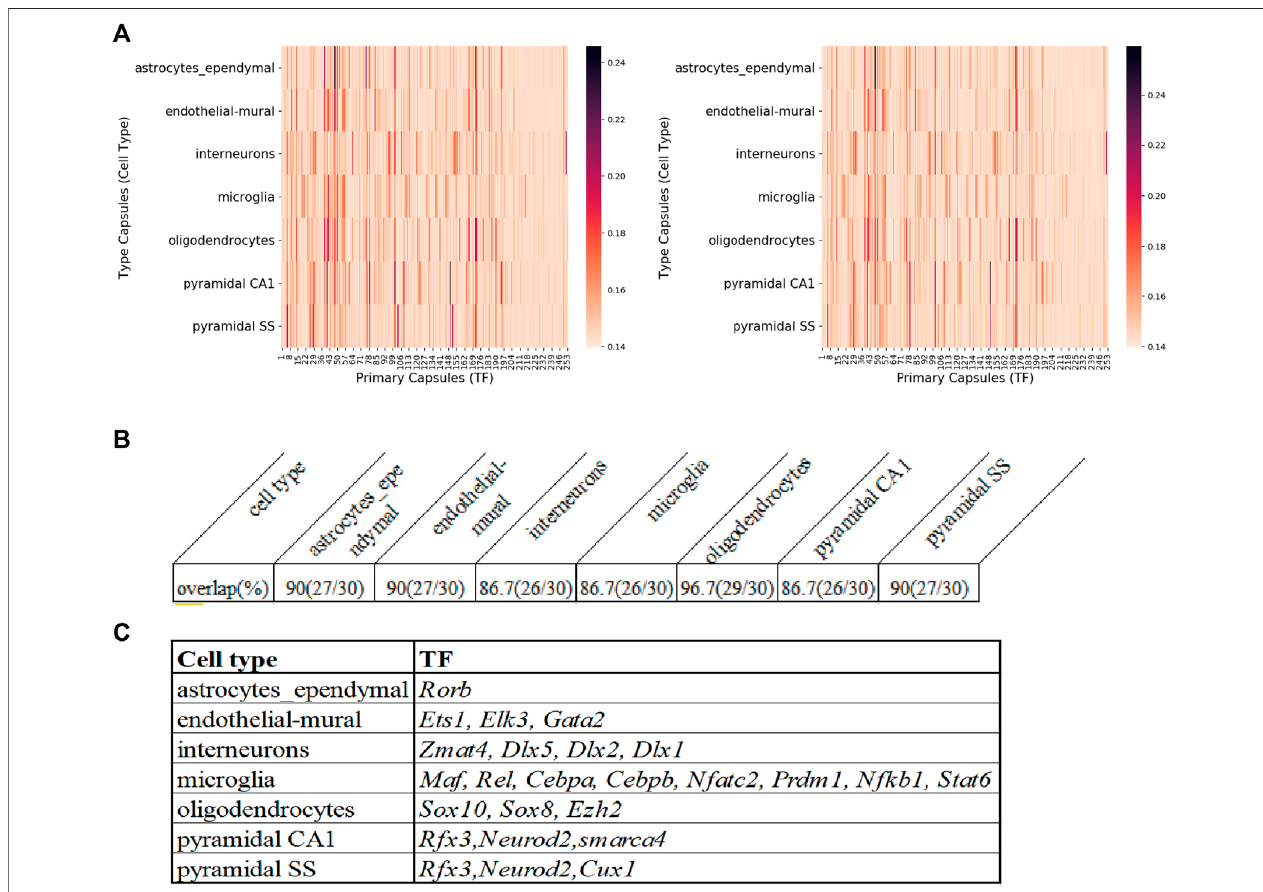
FIGURE 6 | The comparison of MultiCapsNet and SCENIC shows the robustness and interpretability of MultiCapsNet. (A) Averaged overall heatmaps for mouse cortex and hippocampus dataset show that MultiCapsNet perform consistently whether including (left) or excluding (right) the labelling TF from regulon. (B) The top rankedcontributorsforspeci fi ccelltypeclassi fi cationidenti fi edfromdataseteitherincluding (left) orexcluding (right) thelabellingTFarehighlyoverlapped. (C) Thetable list several top ranked contributors for speci fi c cell type recognition, given by both the MuiltCapsNet model and